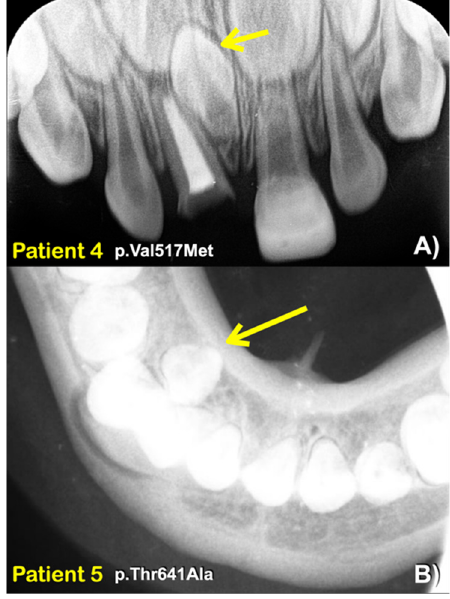
Figure 3. ( A ) Patient 4. A periapical radiograph showing an inverted mesiodens (arrow). ( B ) Patient 5. An occlusal radiograph showing a supernumerary mandibular right premolar (arrow).